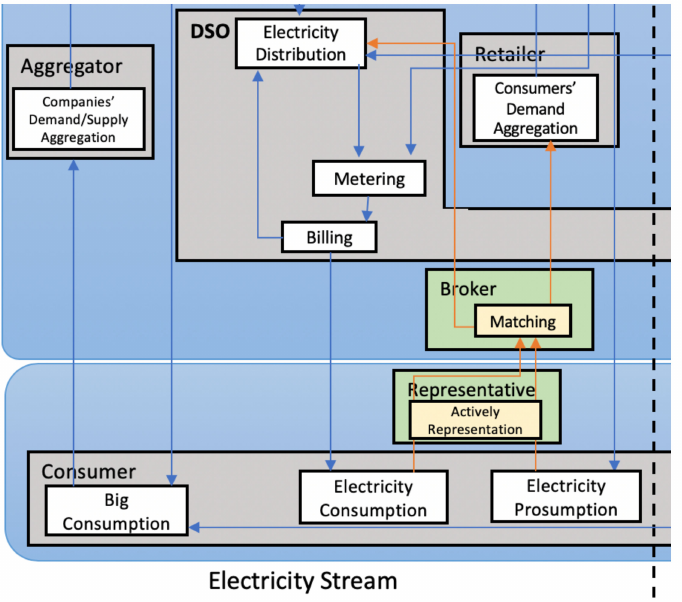
Figure 9. New roles in the future electricity market. Reproduced from [10], Institute of Electrical and Electronics Engineers (IEEE):